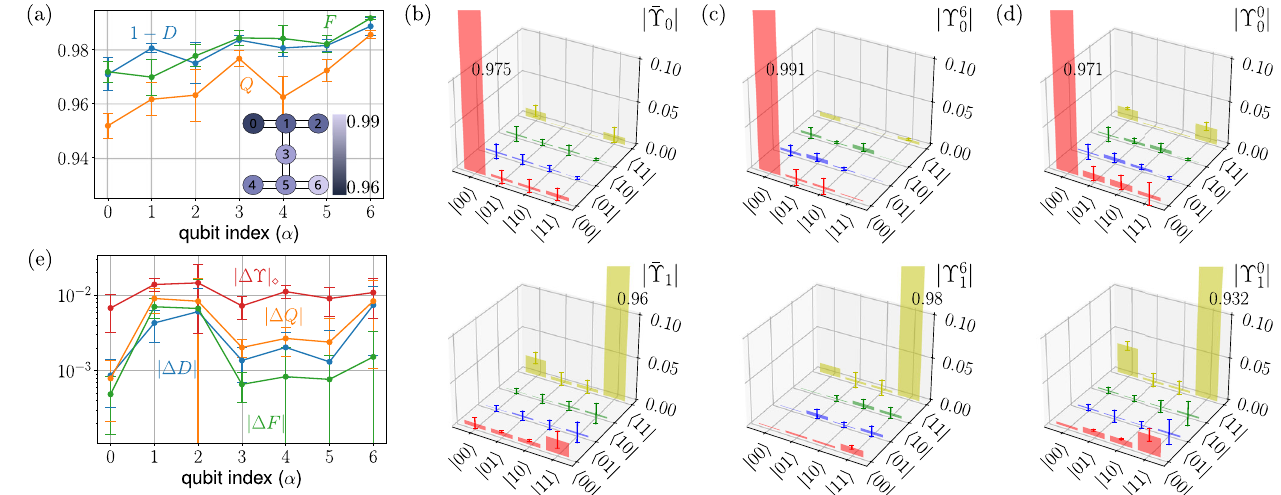
Fig. 2 Experimental tomographic characterization of single-qubit measurements in parallel. a Measurement quanti fi ers: fi delity F (green), QNDness Q (orange), and indestructiveness 1 − D (blue) for each qubit. The inset represents the average performance ( F + Q + 1 − D )/3 of each qubit, as they are located on the ibm_perth quantum processor. b Average Choi matrices ϒ n of all qubits for both measurement and ϒ 0 corresponding to the qubits with best and worst readout performance, respectively. outcomes n = 0, 1. c , d Speci fi c Choi matrices ϒ 6 n n e Error in the quanti fi ers and the Choi operators introduced by the parallelization of the QND-MT. Error bars are the standard deviation estimated with 5 realizations of the